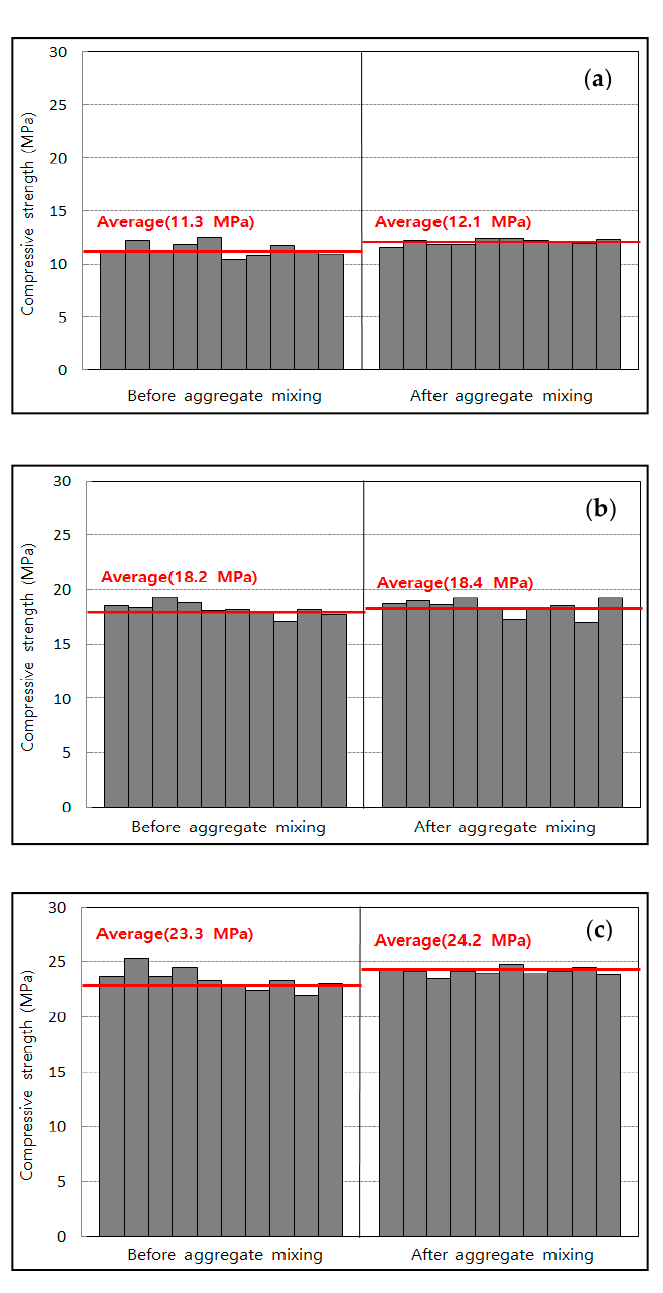
Figure 8. The ( a ) 3-day, ( b ) 7-day, and ( c ) 28-day concrete strength before and after aggregate mixing.